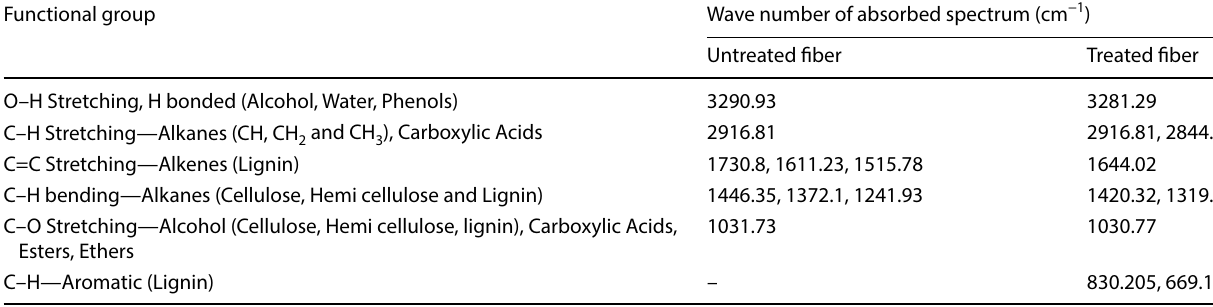
Table 4 FTIR spectrum and its characteristics of untreated and treated Delonix Regia fiber Functional